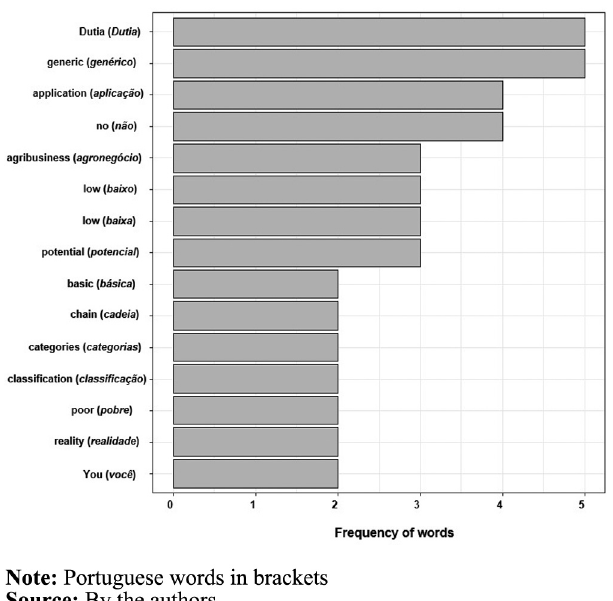
Figure 6. Frequency of the 15 most cited words in the least adherent classi fi cation to the Brazilian